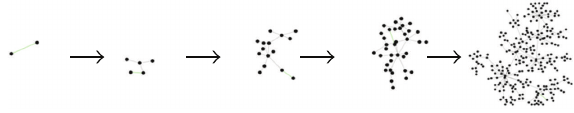
Figure 1: The formation of networks model of opinions spread.